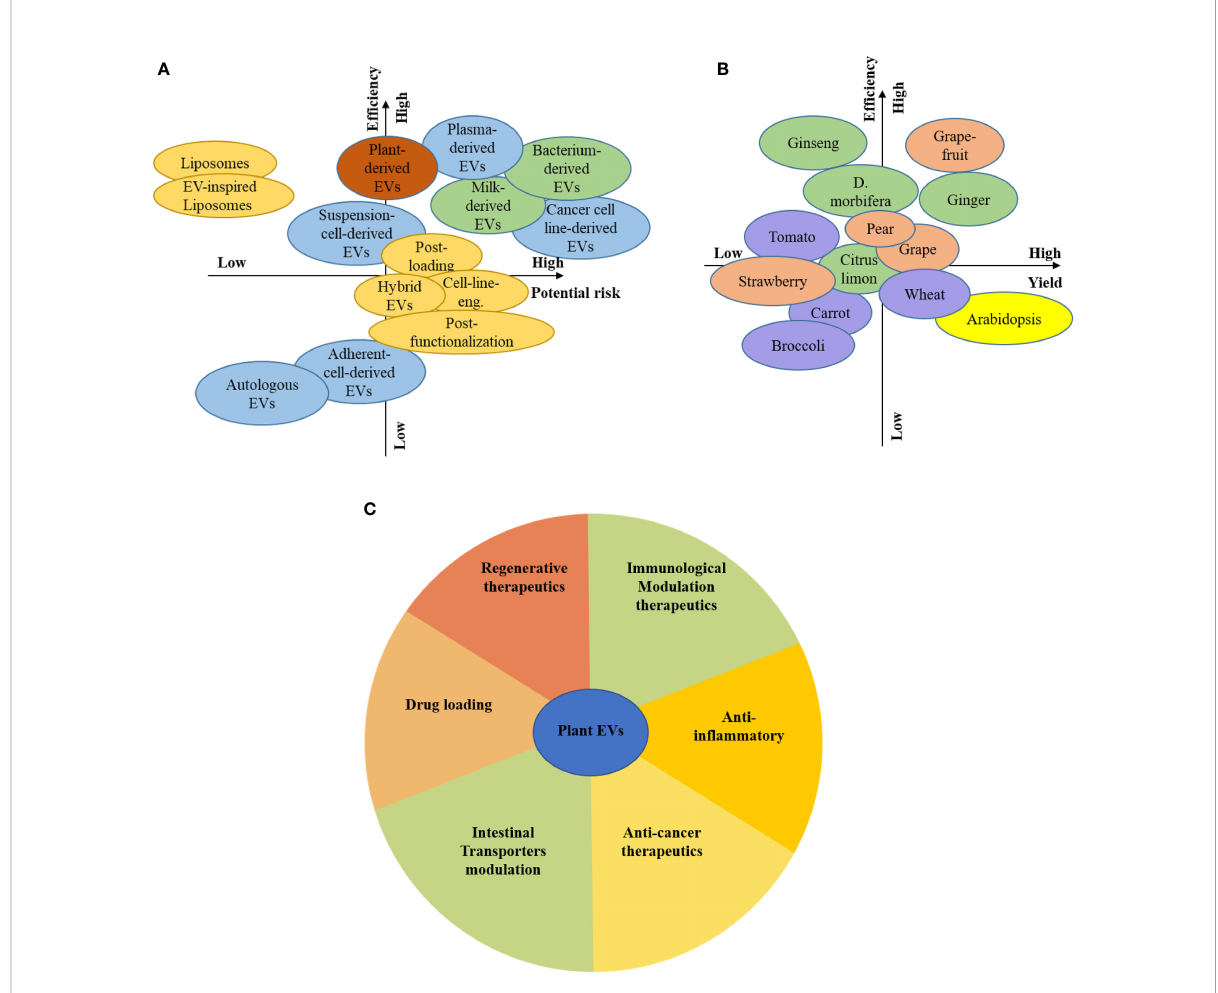
FIGURE 5 Prospects for plant EVs. Consideration of the different source and associated risks and ef fi ciency (A) , Consideration of the plant-based source and associated risks and ef fi ciency (B) , The function of plant-derived EVs by colour-coded guidelines (C)